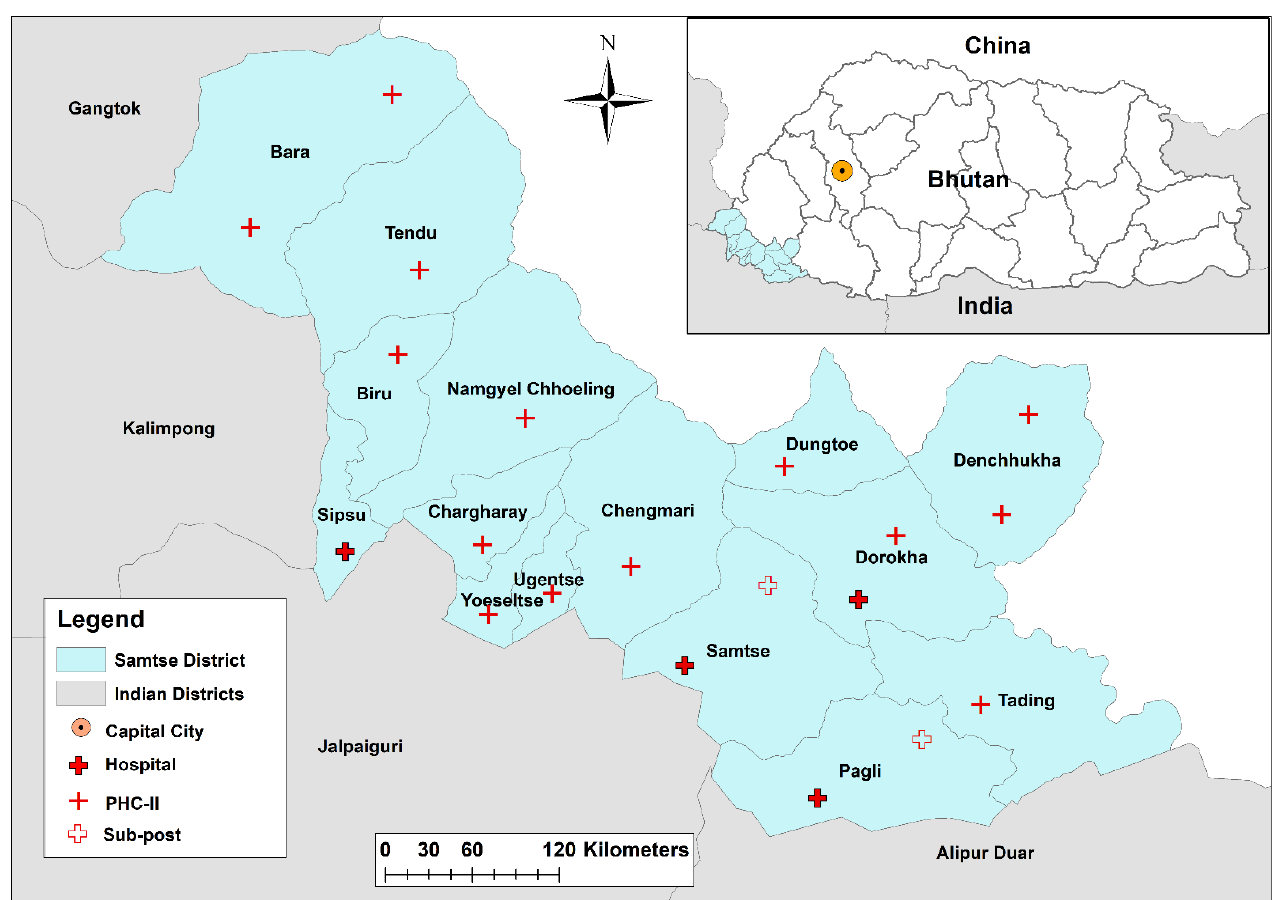
Figure 1. Map of Bhutan showing Samtse District and its health centres in 2021. PHC—Primary Health Centre. Note: This map is not authoritative on its international boundary. Health Centre. Note: This map is not authoritative on its international